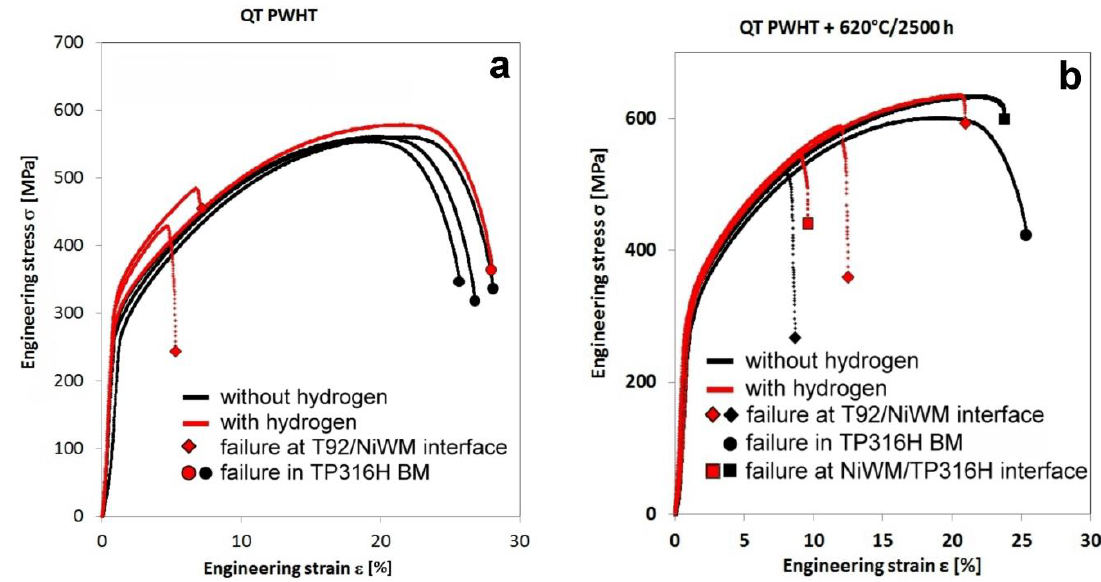
Figure 9. E ff ects of isothermal aging at 620 ◦ C and electrochemical hydrogen charging on the Figure 9 . Effects of isothermal aging at 620 °C and electrochemical hydrogen charging on the room- room-temperature tensile deformation behavior of T92 / TP316H dissimilar weldments, states: QT temperature tensile deformation behavior of T92/TP316H dissimilar weldments, states: QT PWHT PWHT ( a ); QT PWHT + 620 ◦ C / 2500 h ( b ). ( a ); QT PWHT + 620 °C/2500 h ( b ).